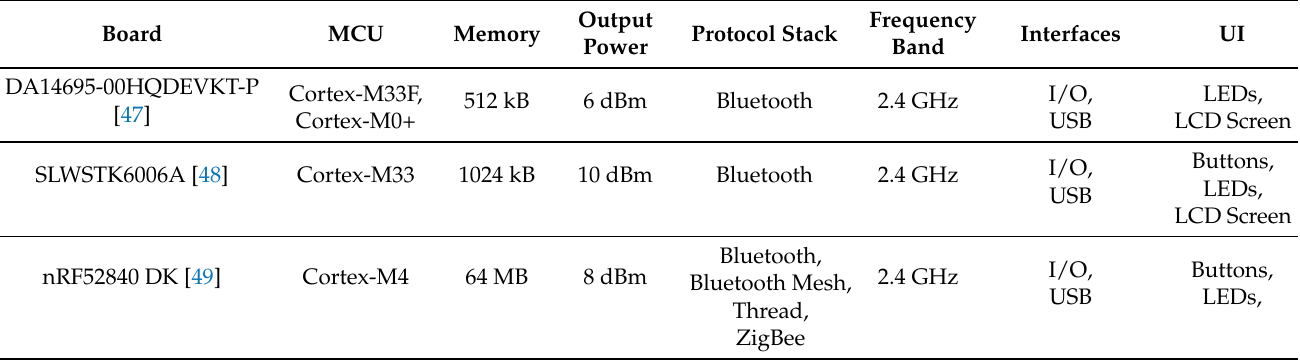
Table 1. Prototyping boards